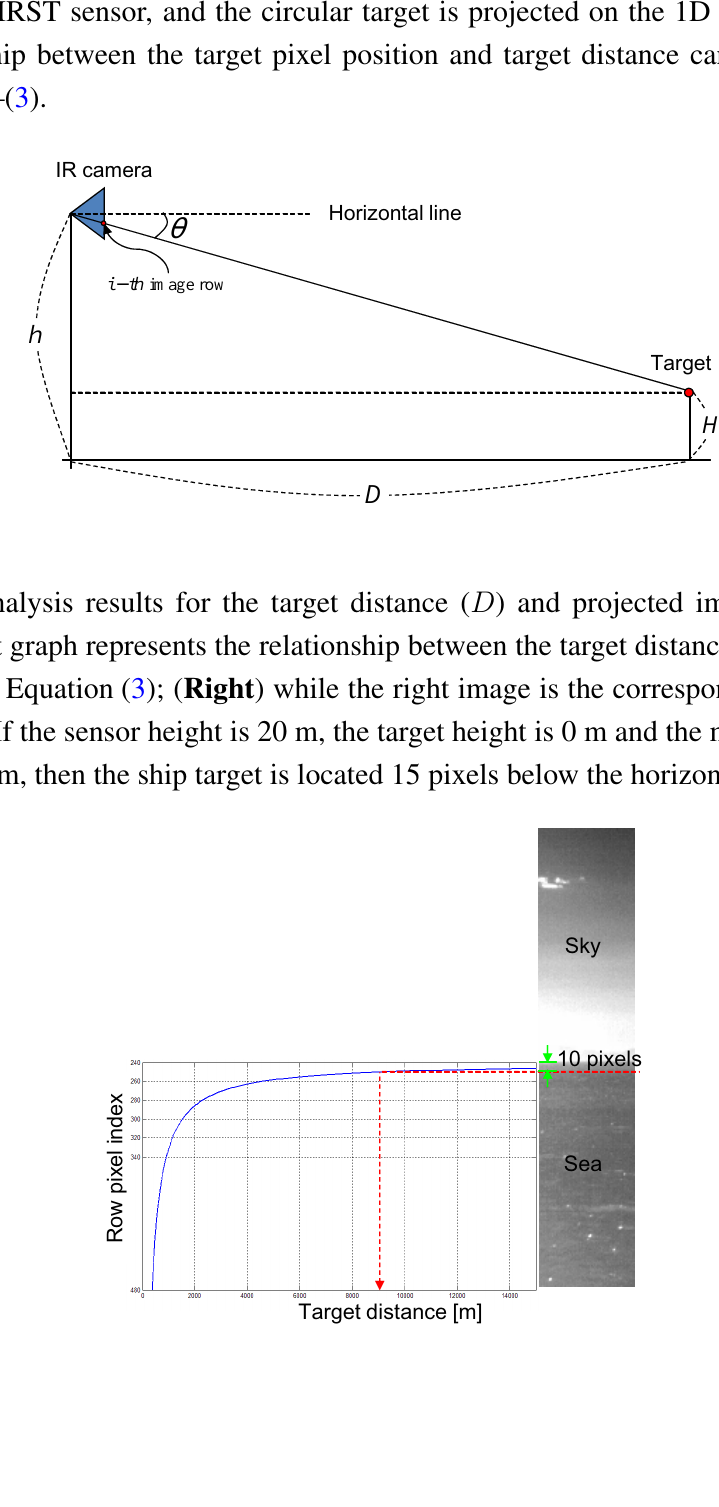
Figure 3. Simplified IRST projective geometry by assuming a flat surface. The triangle represents an IRST sensor, and the circular target is projected on the 1D infrared detector.